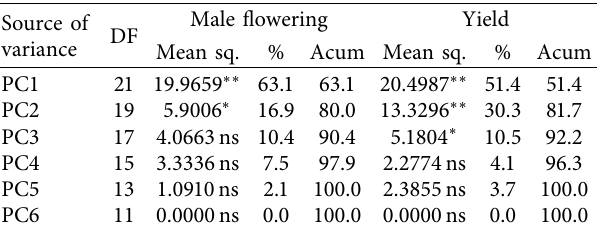
Table 4: AMMI analysis for earliness and yield of sweet corn in West Java. Male flowering Yield Source of DF variance Mean sq. Acum Mean sq.